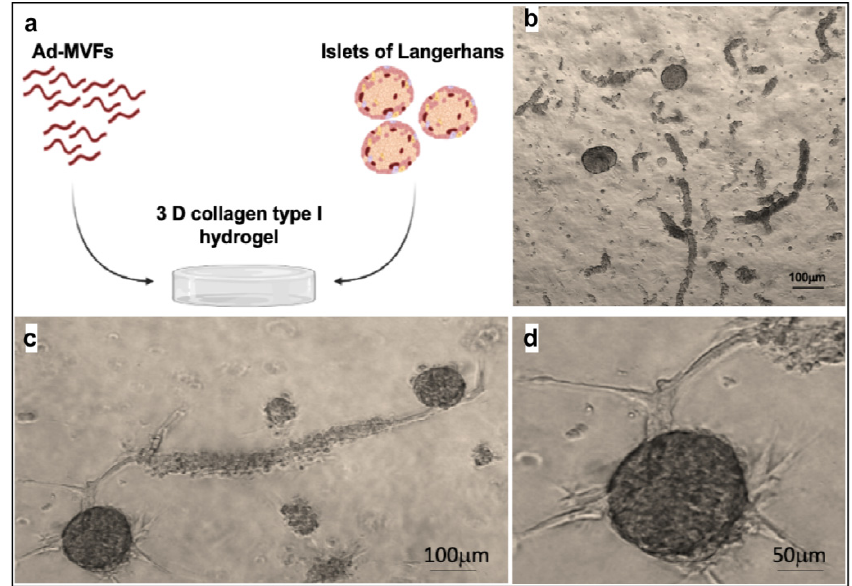
Figure 8. Langerhans islets and ad-MVFs cocultured in 3D collagen hydrogel. ( a ) Schematic representation of the coculture system. ( b ) Optical microscopy image of islets and ad-MVFs cocultured in 3D collagen hydrogel at day 0. ( c ) Optical microscopy image of Langerhans islets and ad-MVFs cocultured in 3D collagen hydrogel at day 8. ( d ) Magnification of a vascularized islet at day 8.